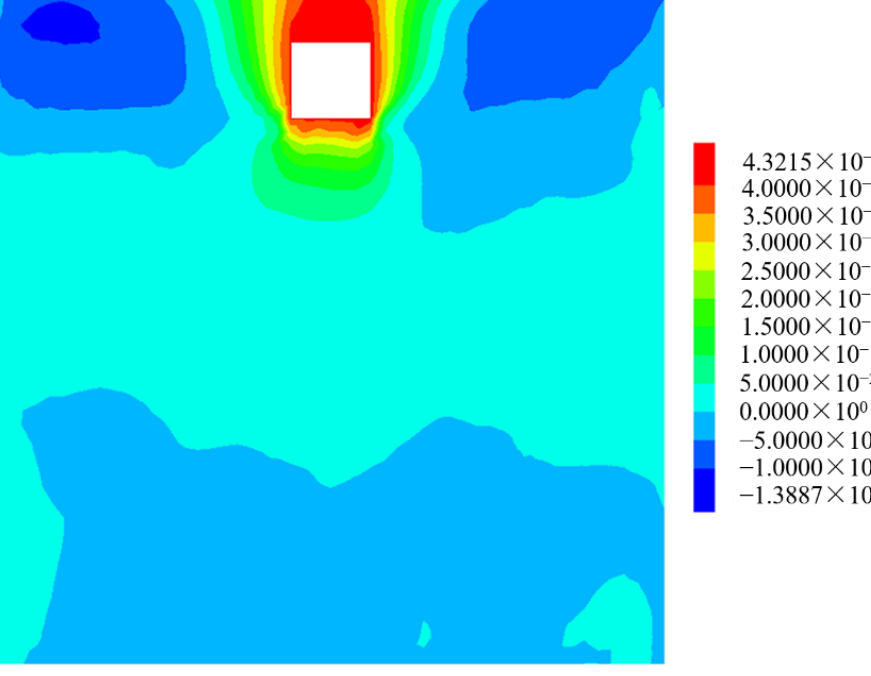
Figure 22. Displacement vector diagram of soil around tunnel structure. 5. Conclusions In this study, dynamic response characteristics of foundation soil and tunnel struc- ture were studied under four kinds of tunnel depth conditions by considering soil anisot- ropy random field, including the analysis of soil excess pore water pressure ratio, foun- dation liquefaction range, tunnel floating displacement and surface deformation. Based on the results of calculation and analysis, the main conclusions were as follows: (1) The excessive static pore pressure ratio and soil liquefaction range are greatly af- fected by the change in the tunnel embedment depth. With depth increasing, the soil excess pore water pressure ratio under the tunnel gradually decreases and the lique- faction degree reduces. The peak value of the foundation liquefaction range increases with the increase of embedment depth, and the time history of the liquefaction range rises faster over time in the ascending stage, while decreasing faster over time in the descending stage. (2) The tunnel depth has the same effect on the maximum uplift displacement of the tunnel and the ground surface. With the increase of embedment depth, the thickness